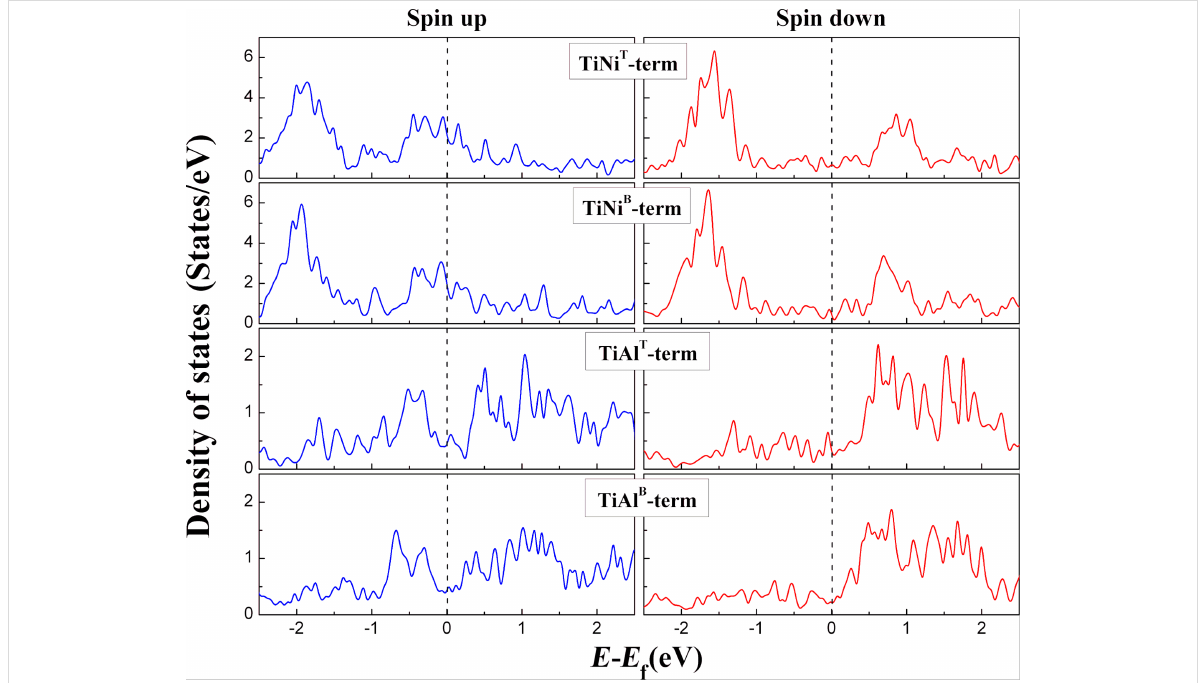
Figure 3: Density of states of the interface of the Ti 2 NiAl/Ag/Ti 2 NiAl device with different atomic terminated interface.